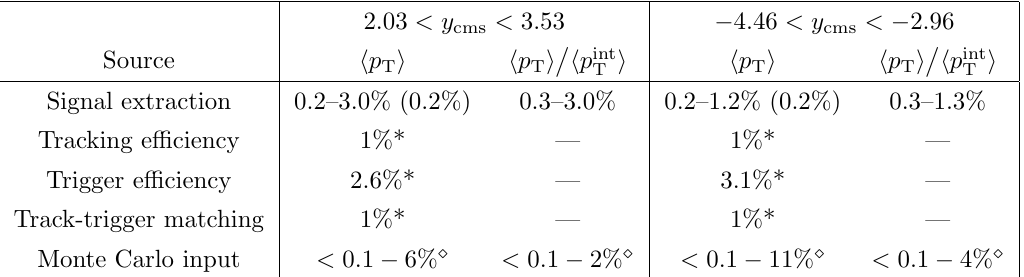
Table 3 . Systematic uncertainty sources on the average and normalized average p T . The values in parentheses correspond to the multiplicity-integrated uncertainties related to the signal extraction. The contributions marked with an asterisk are correlated in multiplicity. The uncertainty on MC input, marked with a diamond, is partially correlated in